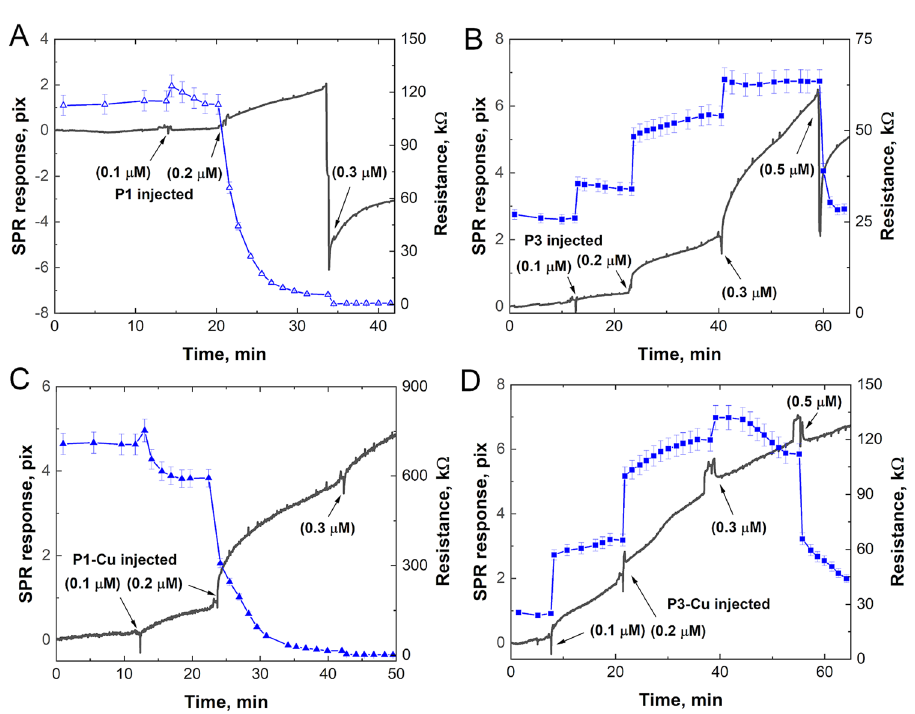
Figure 3. SPR/EIS of P1 and P3 with or without Cu 2+ . The black curves are the SPR responses, and the blue curves are the calculated bilayer resistance values from EIS measurements. Peptides were added in small increments on top of a stable POPC tBLM. SPR/EIS signals were collected simultaneously as a function of time: ( A ) P1, ( B ) P3, ( C ) P1-Cu 2+ , and ( D ) P3-Cu 2+ . The peptides were metallated using a 1:1 stoichiometric amount of CuCl 2 . See also Fig. S3. (µM =